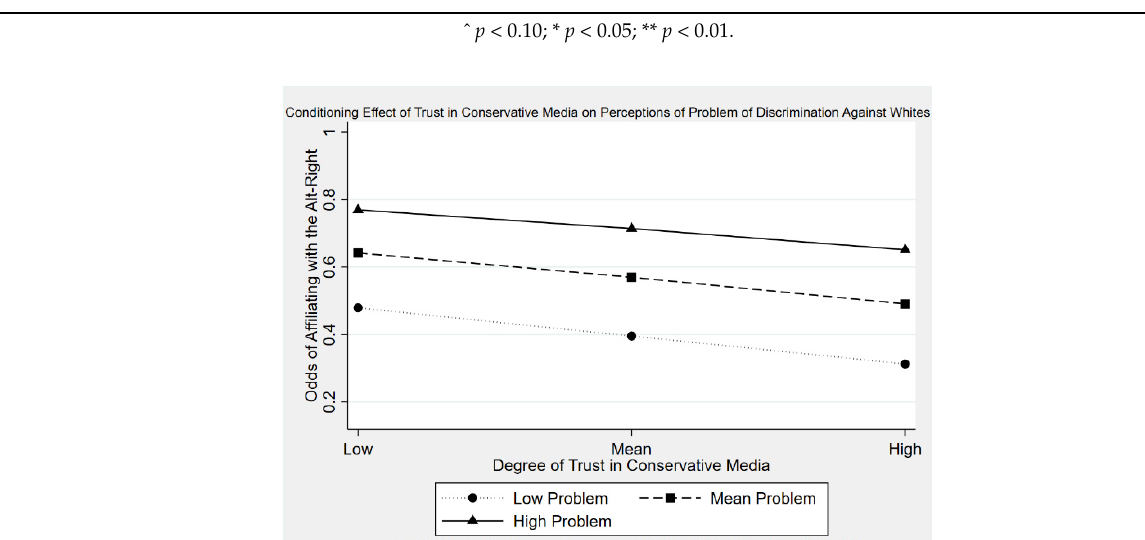
Figure 5. Conditioning Effect of Conservative Media: Government Corruption and the Alt-Right.